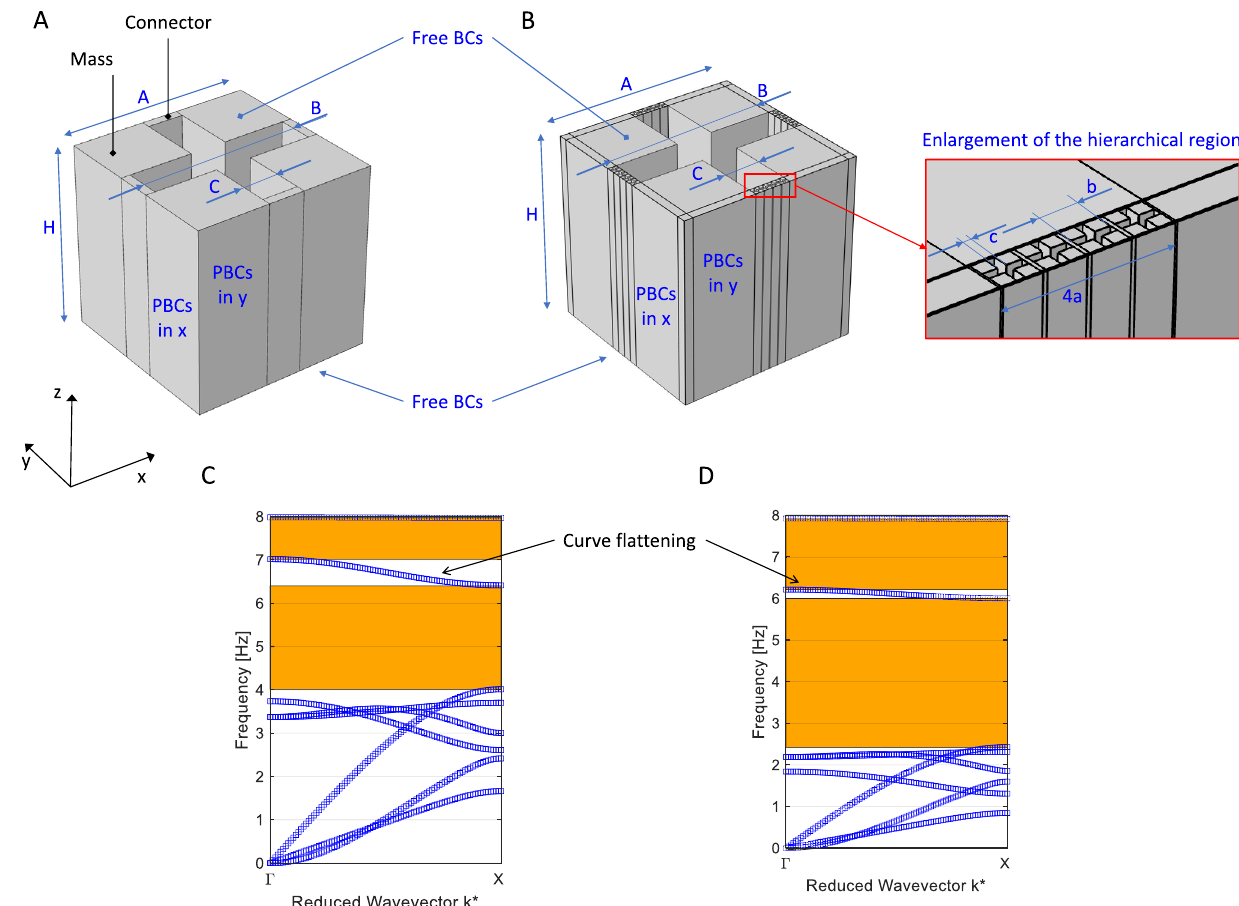
Fig. 1. Dispersion diagrams I − free/free assumption. (A) Schematic representation of the FE models for the ordinary and (B) hierarchical large-scale metamaterial (the inset provides an enlargement of the region where the second hierarchical level is introduced) under the assumption of free-free boundary conditions (BCs) applied to the top and bottom surfaces of the unit cell and periodic boundary conditions (PBCs) at lateral surfaces. Dispersion curves of the (C) ordinary and (D) hierarchical large-scale elastic metamaterial, showing a remarkable enhancement of the width of the BGs (orange rectangles) and their shift towards lower frequencies. Geometrical parameters of the unit cells for both ordinary and hierarchical structure are provided in the text.